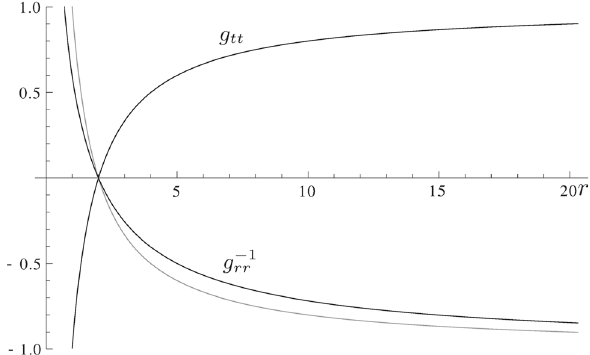
Fig. 2 Case b = 3. Metric components for α = − 0 . 7 and a = 1 . 4 (blacklines)comparedtotheSchwarzschildcomponent g − 1 rr (grayline). The mass M = 1